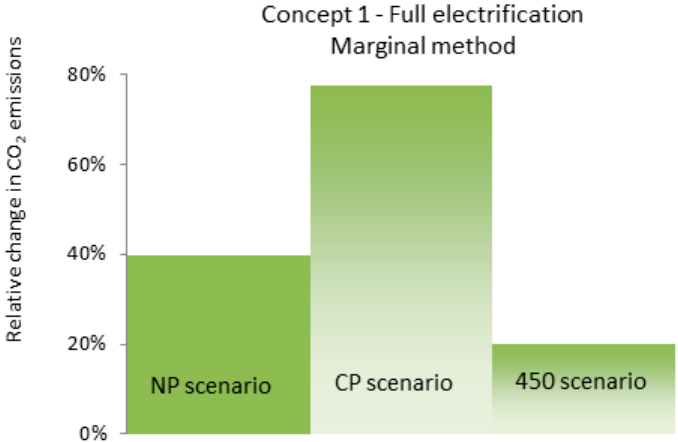
Figure 16. Relative change of CO 2 emissions of full electrification ( Concept 1 ) compared to the utilization of gas turbine cycles ( Concept 0 ) when the marginal method is applied to calculate the CO 2 -factor.